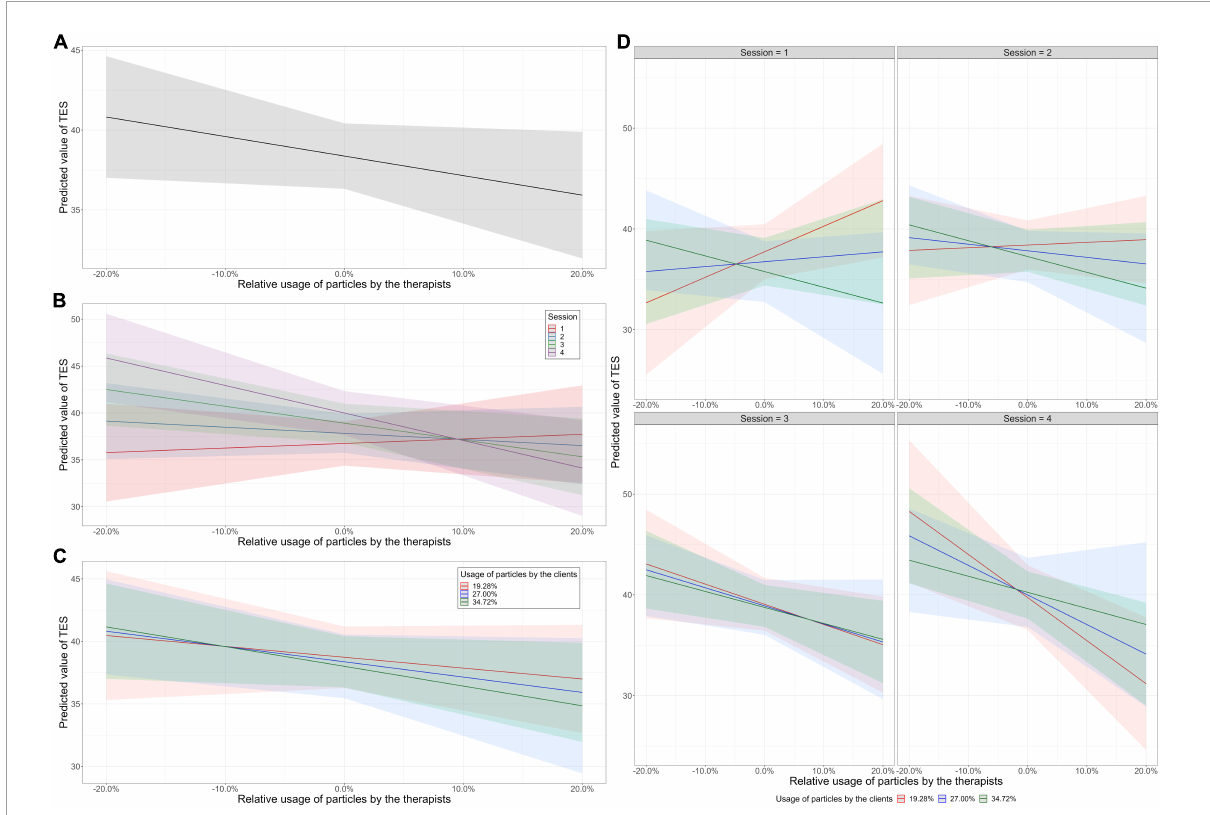
FIGURE1 Results of multilevel modeling (Model 3). (A) Main effects of relative usage of particles by the therapists on TES scores. (B) Interaction effects between the relative usage of particles by the therapists and session number on TES scores. (C) Interaction effects between the relative usage of particles by the therapists and the usage of particles by the clients on TES scores. (D) Interaction effects between relative usage of particles by the therapists, the usage of particles by the clients, and session number on TES scores.